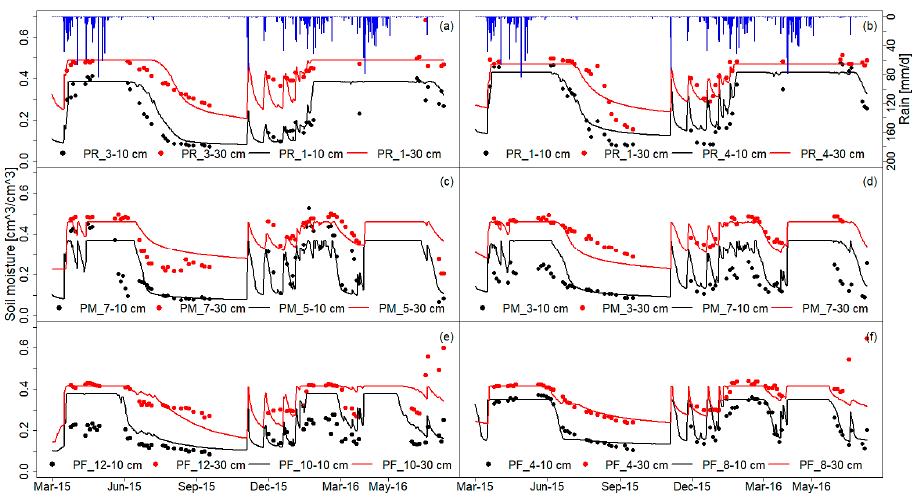
Figure 7. Modeled and measured soil moisture content from selected plots at depths of 10 and 30 cm in each hydrological zone. PR, PM, PF represent riparian, middle, and fringe zones, respectively. ( a , b ) Riparian; ( c , d ) middle; and ( e , f ) fringe zones. 1, 3, 4, 5, 7, 8, 10, and 12 denote plot numbers at the different hydrological zones.